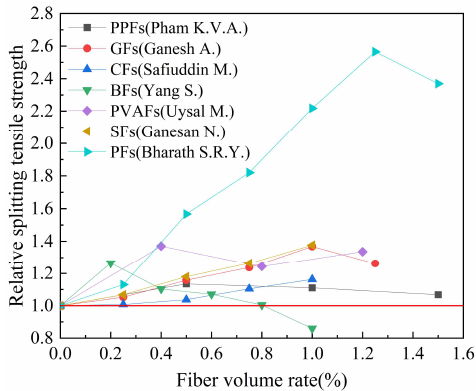
Figure 16. The effect of fiber type on splitting tensile strength.